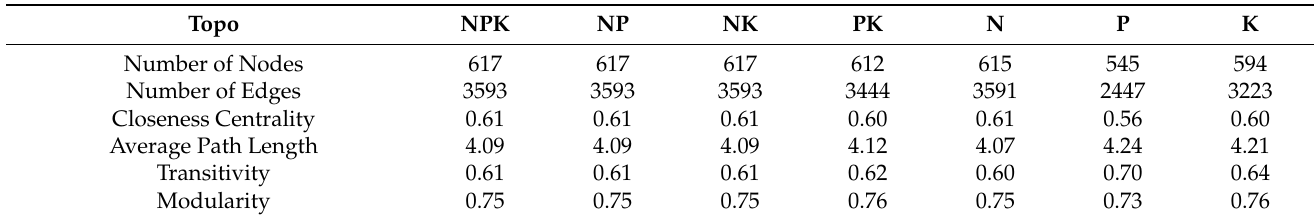
Table 3. Topological parameters of bacterial network of different NPK fertilization conditions.